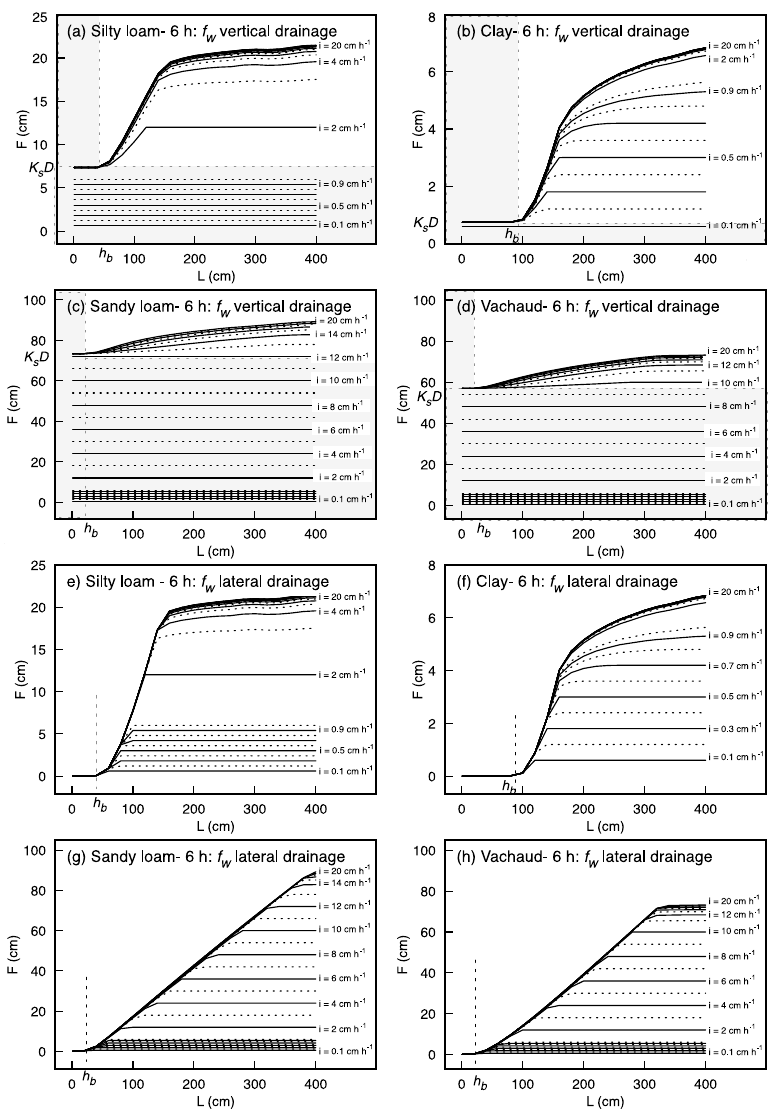
Figure 9. Change in cumulative infiltration ( F) as a function of rainfall rate ( i ) and water table depth ( L) under nonponded initial conditions after a rainfall duration D = 6h for the four types of soils in Table 1 and two end drainage bottom boundary conditions ( f w ) : (a–d) vertical and (e–h) lateral (S o = 0 . 02, b = 1m, and here K sh = K s from Table 1). The isolines describe the change of F with water table depth for the same rainfall rate ( i) ; h b is the bubbling pressure (capillary fringe) for each soil type (Table